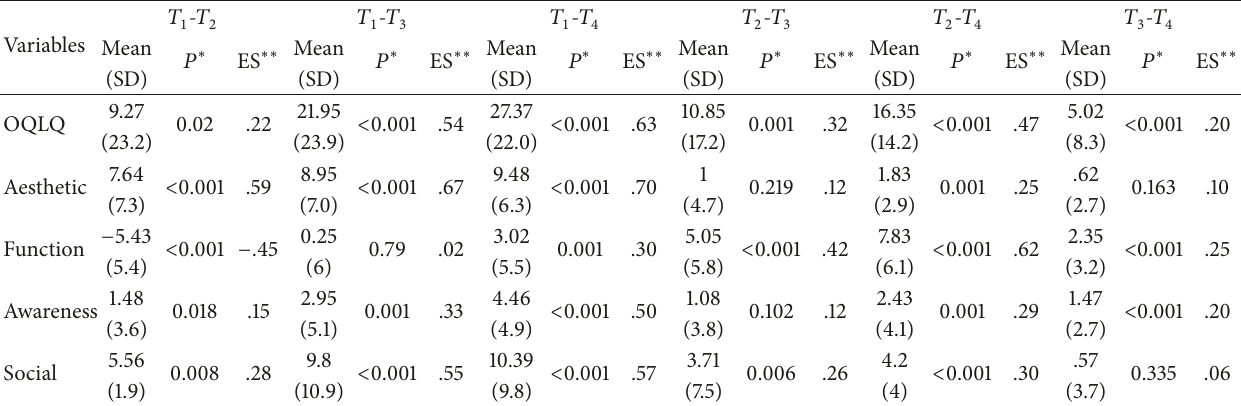
Table 4: Comparison of OQLQ and its subdomains from baseline ( 𝑇 1) to postoperative 6+ months ( 𝑇